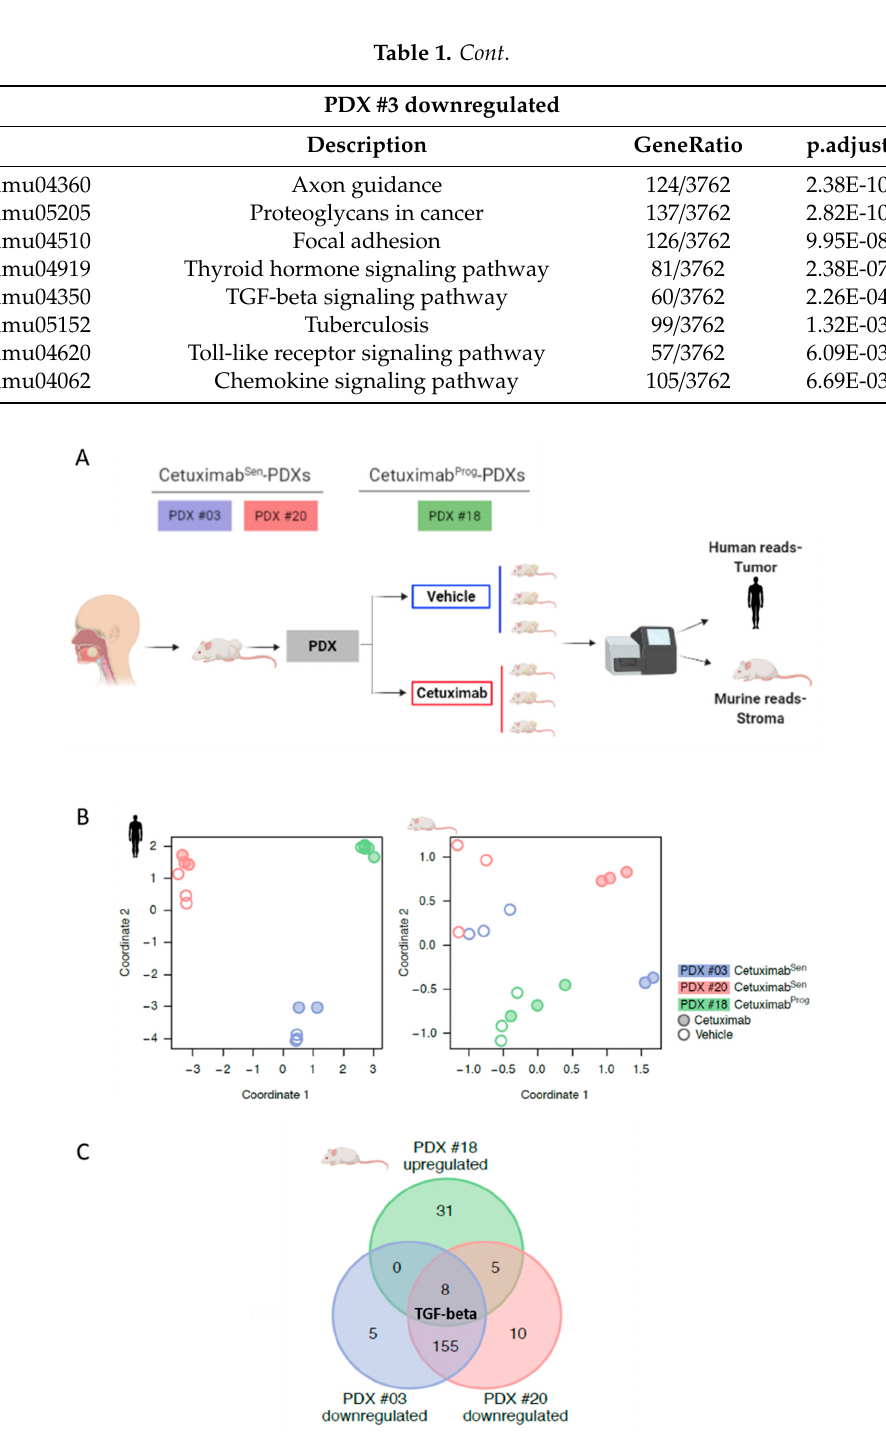
Figure 2. Molecular characterization of Cetuximab Sen and Cetuximab Prog PDXs. ( A ) Design of the RNA-seq experiment, created with BioRender © 2019. ( B ) Multidimensional scaling (MDS) plot based on expression variation among all analyzed samples. Each circle represents a sample. Circle colors denote patients sensitive (red and blue) and nonsensitive (green) to cetuximab treatment. Filled circles denote samples after cetuximab treatment, whereas empty circles denote samples after vehicle treatment. The left panel is based on the human (tumor) reads and the right panel is based on the murine (stroma) reads. ( C ) Venn diagram of KEGG pathways enriched in the murine (stroma) compartment for upregulated genes (log2FC < 0.5) of PDX #18 and downregulated genes (log2FC > 0.5) of PDX #03 and #20. The transforming growth factor-beta (TGF-beta) pathway is common for all three and lies in the